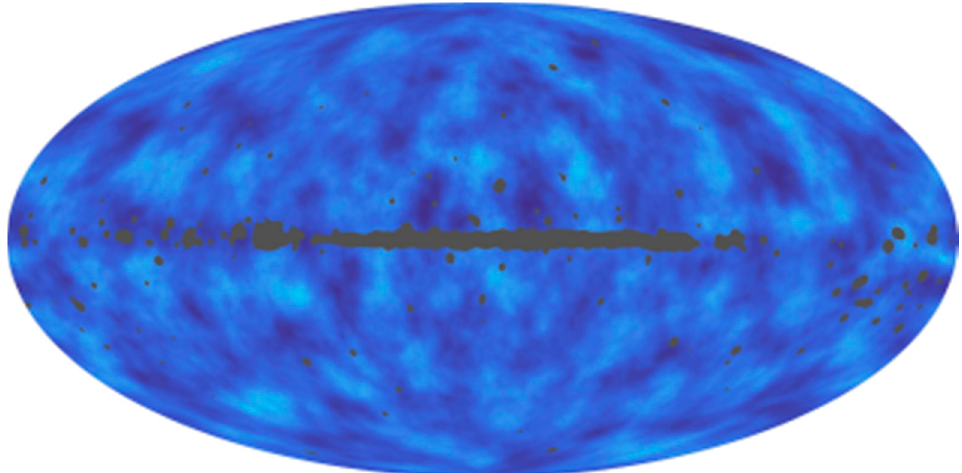
Figure 14. All-sky map of the CMB lensing potential constructed from the Planck 2015 data. Lighter regions correspond to integrated overdensities, darker to underdensities. The grey regions, where Galactic and extragalactic foregrounds are large, are masked in the analysis. Image credit: ESA and the Planck Collaboration.